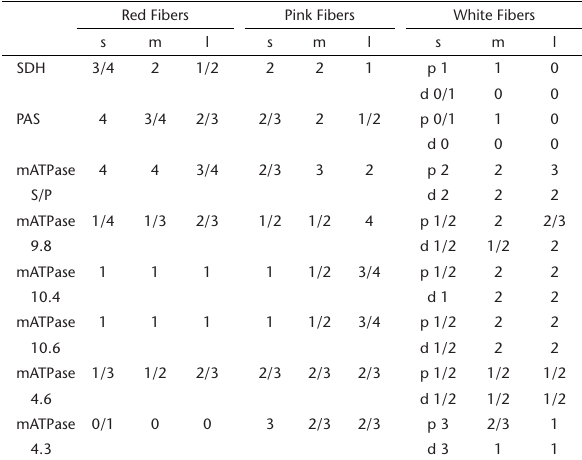
Table 1. Histochemistry of the adductor pectoral fin muscle of Micropogonias furnieri